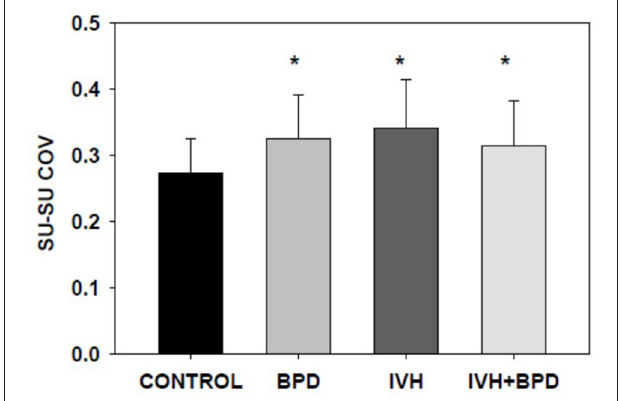
FIGURE 3 | Suck-suck COV at > 35 weeks PMA. In premature infants 35–42 weeks PMA, suck-suck rhythm is more stable in control LRP infants compared to infants with BPD and those with IVH ( p < 0.05; ANOVA, Dunnet’s post-hoc test). Infants with both IVH and BPD approached significance ( p = 0.1). No additive or synergistic effect was noted. * p < 0.05 vs. LRP. Data is given as mean ±